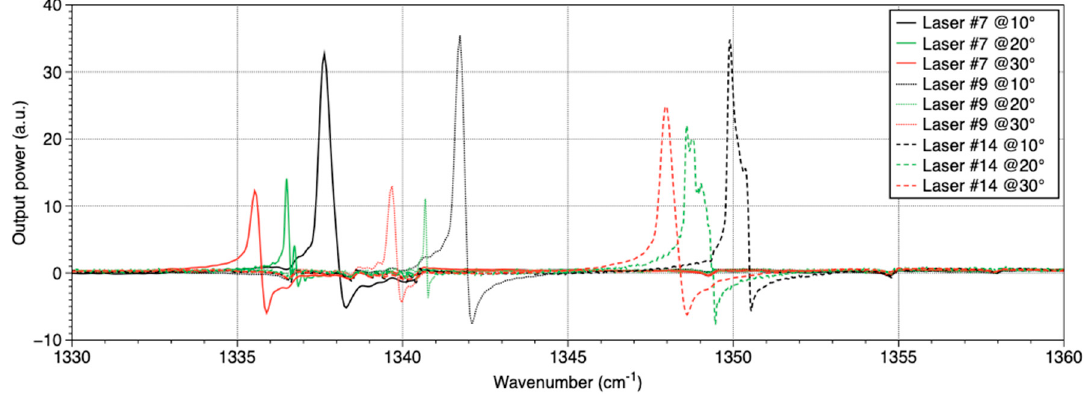
Figure 3. Emission spectra of the QCLs #7, #9, and #14 from the DFB QCL array for three temperatures.